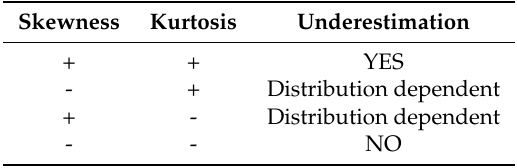
Table 2. Conditions for underestimation of the